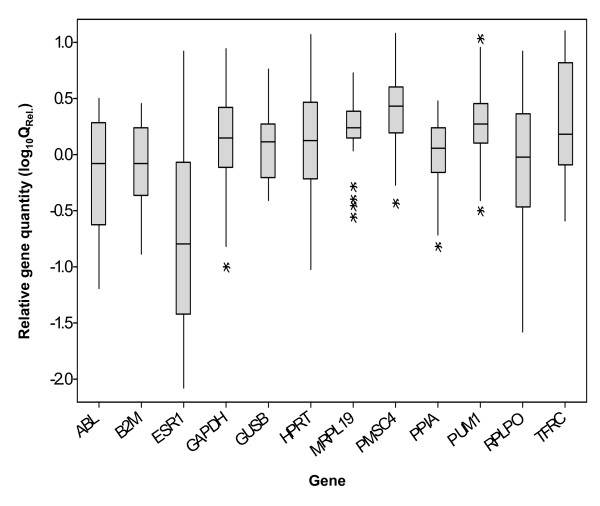
Quantity of all genes expressed in breast tissues relative to calibrator (QRel. = E-ΔCt). A pool of cDNA from two normal tissues was used as calibrator.